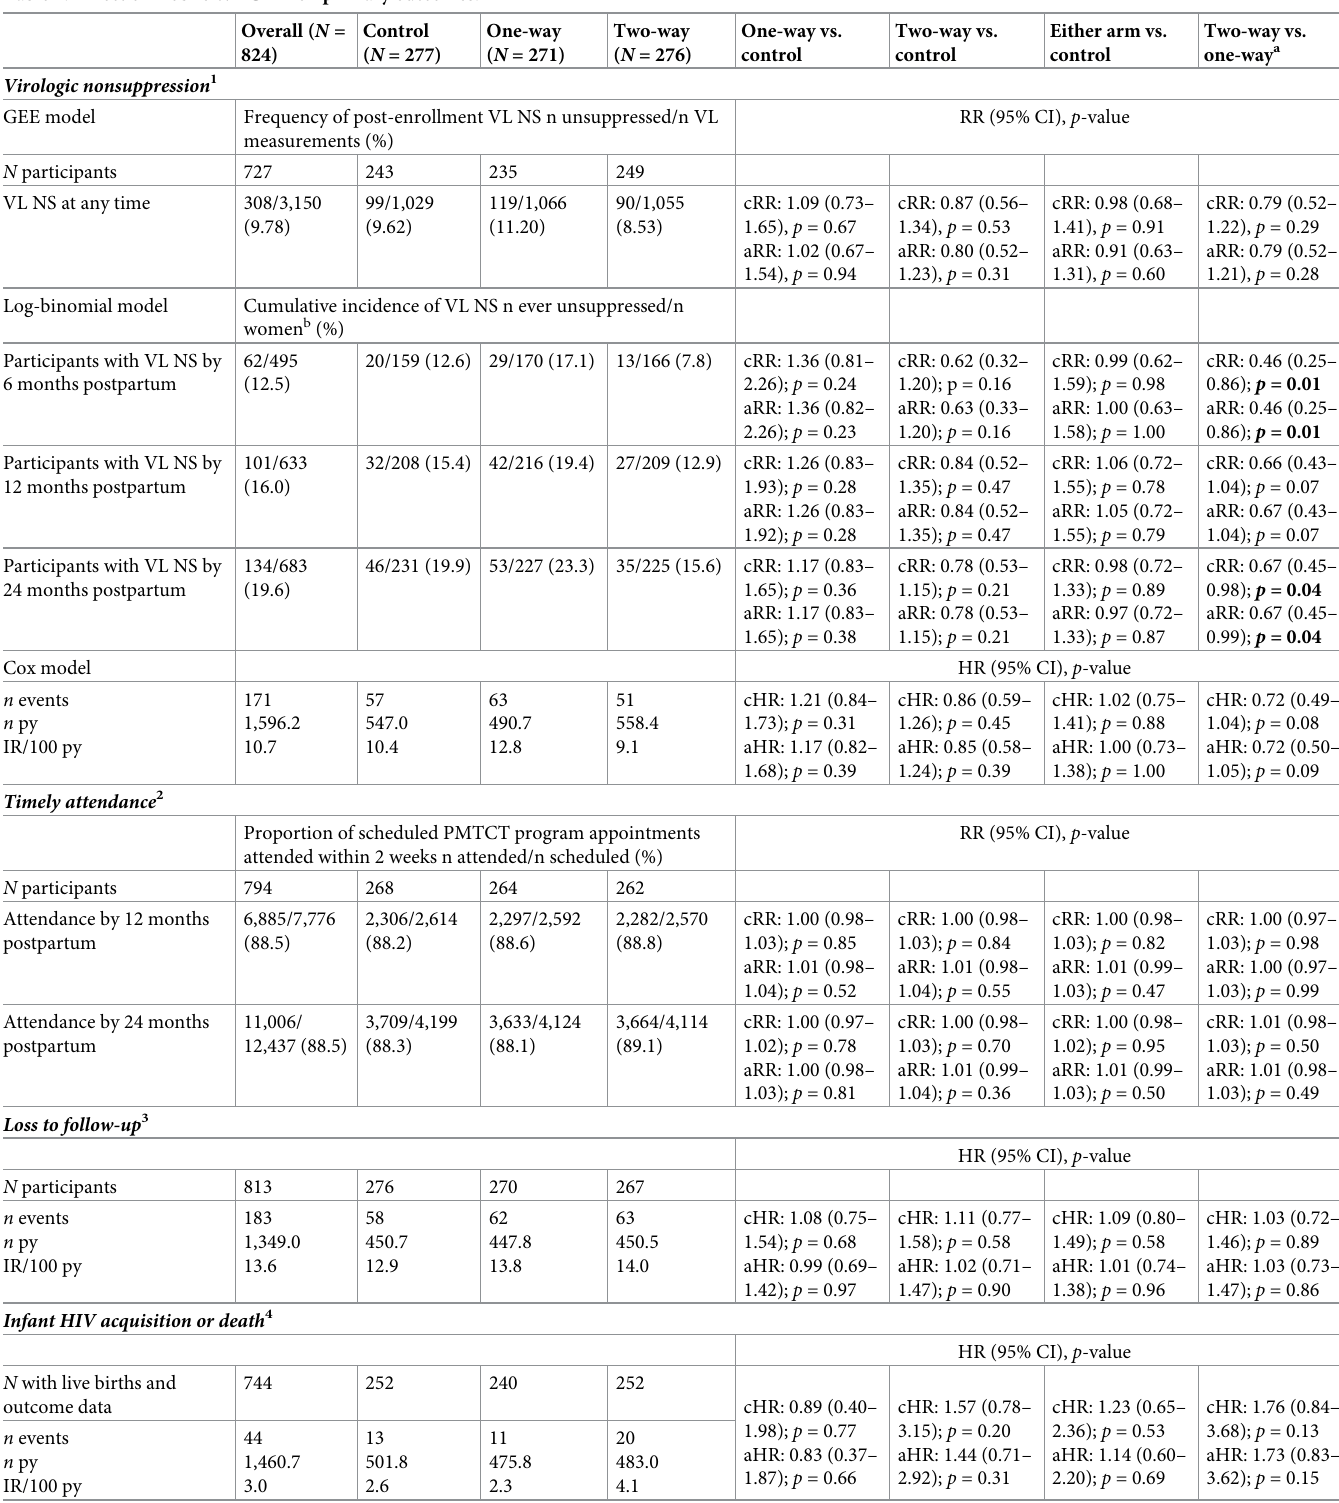
Table 2. Effect of Mobile WACh-X on primary